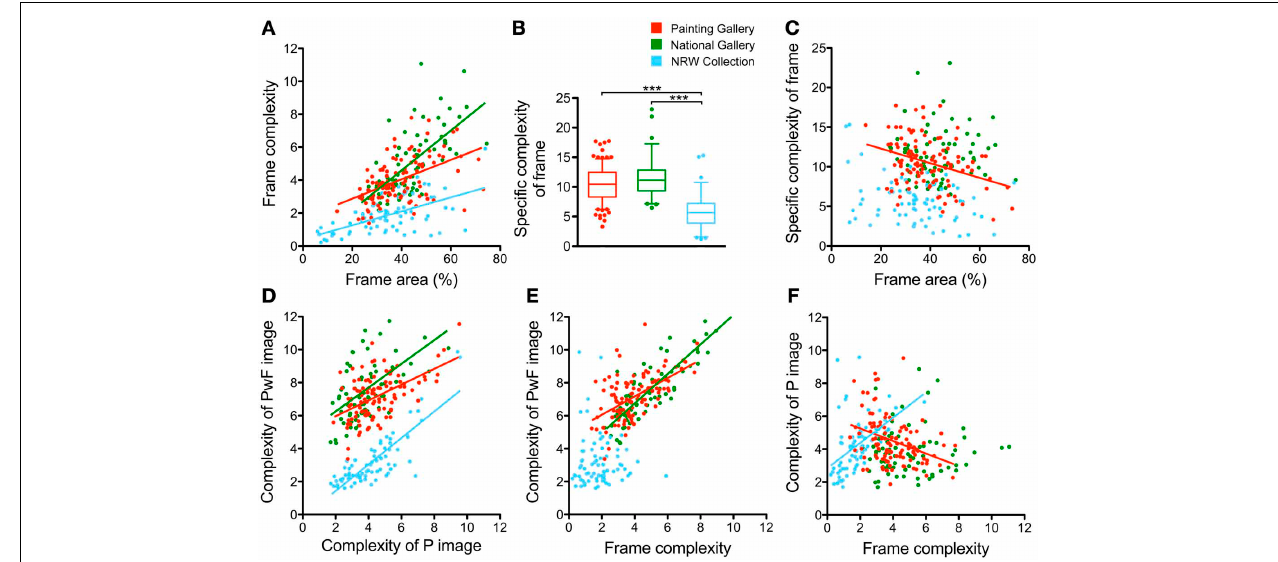
FIGURE 10 | Some relations between frame area, frame complexity and complexity of the paintings. Scatter graphs (A,C–F) for different combinations of measures are shown (see labeling of the x axis and y axis). Each dot represents one painting. Colors represent the different museums, as indicated in (B) . The colored regression lines represent significant results